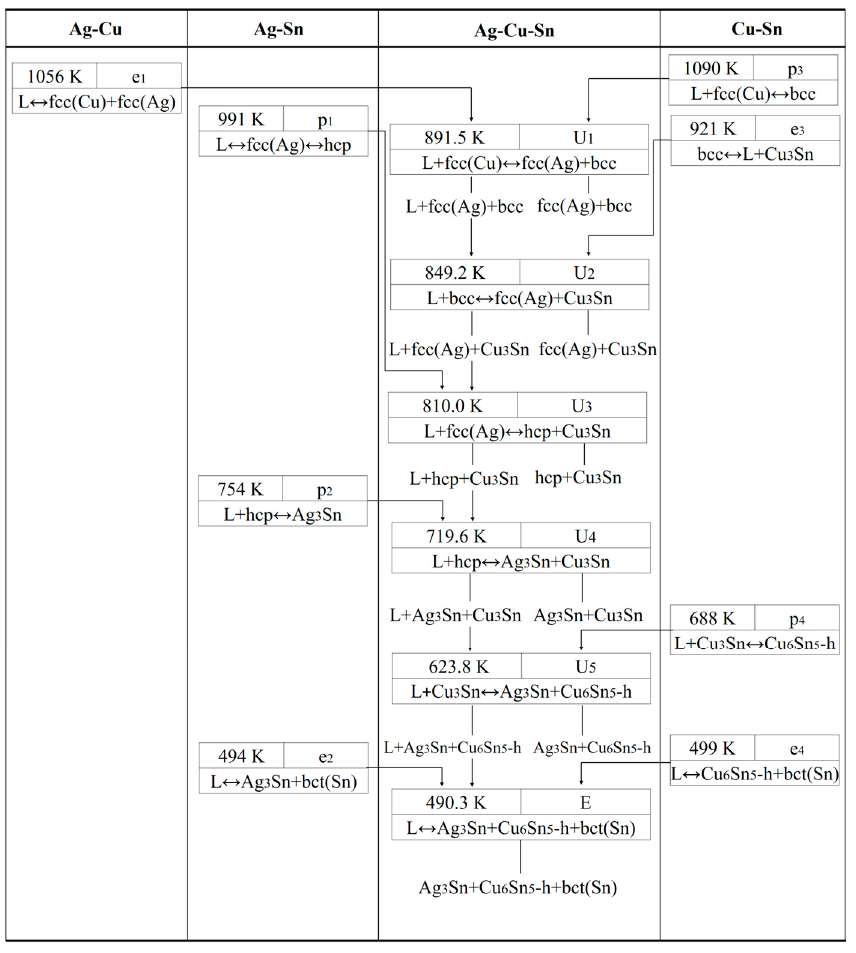
Figure 3. The reaction scheme in the Ag-Cu-Sn ternary system. Figure 7 is the calculated enthalpies of mixing of the liquid Ag-Cu-Sn alloys at 773 K, 973 K and 1173 K (referenced states: liquid Ag, liquid Cu and liquid Sn) along different cross sections ( x Ag : x Cu = 1 : 3, x Ag : x Cu = 3 : 1, x Ag : x Cu = 1 : 1) with